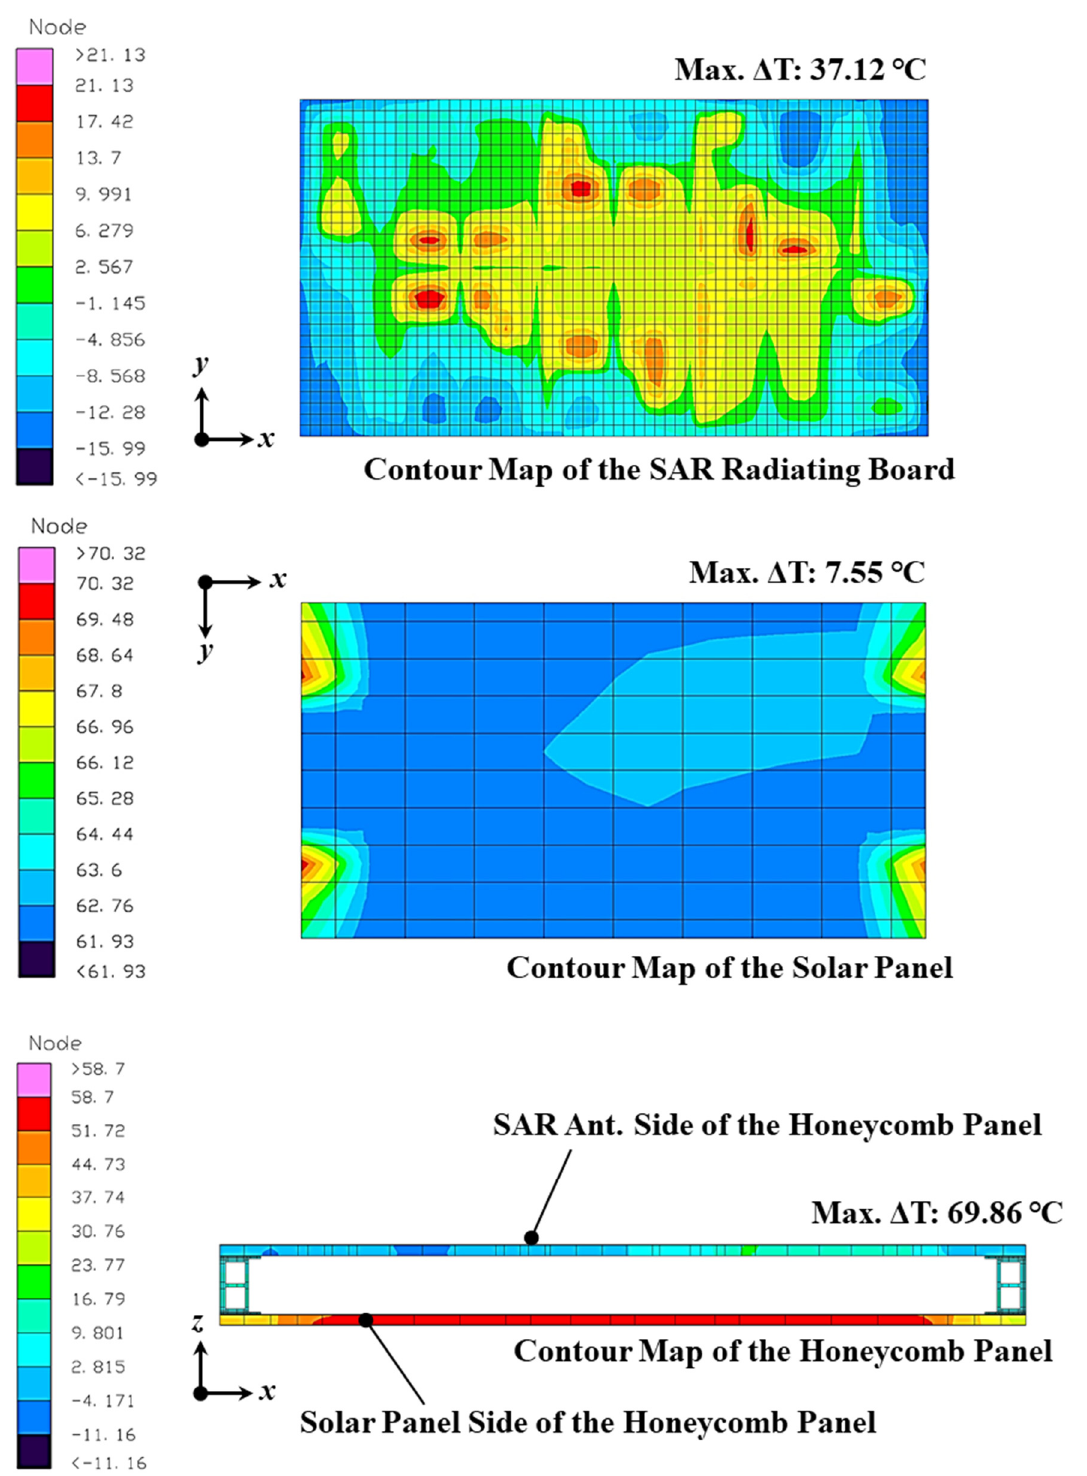
Figure 13. Worst thermal gradient contours of the satellite platform, SAR antenna, and solar panel during the SAR imaging operation mode in the worst cold case.